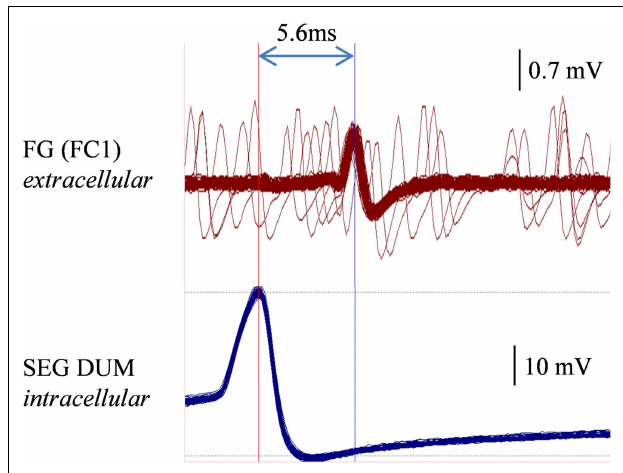
FIGURE 9 | Overlaying multiple sweeps recorded a preparation similar to the one shown in Figures 7 and 8, while stimulating the same DUM neuron. Stimulation resulted in a similar disruptive effect on the FG. Sweeps were triggered by the consecutive action potentials of the stimulated DUM neuron (lower trace, left vertical line). A corresponding spike in the extracellular recording of the FG FC1 nerve is clearly seen (upper trace, right vertical